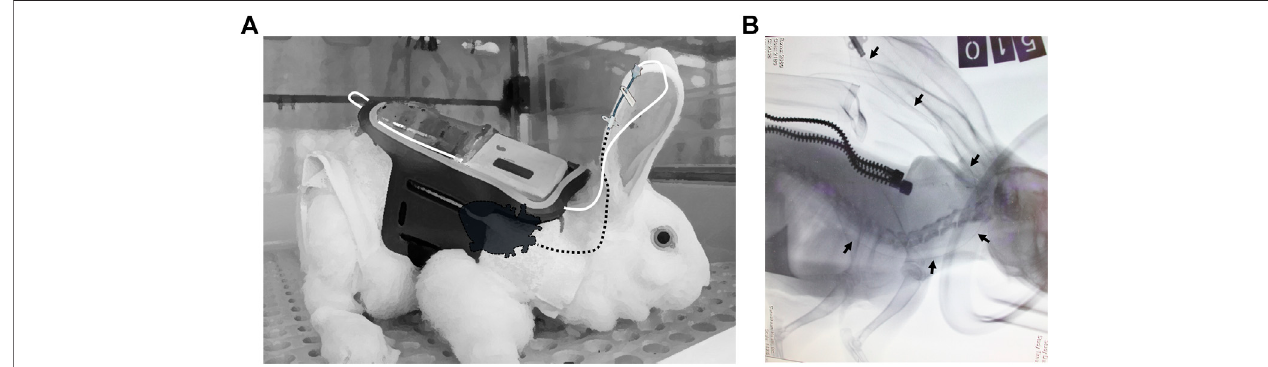
FIGURE1| PICCinsertion (A) Illustrationoftheconnectionbetweenthepumpandcatheter.Thecarriedpumpisharnessedtothebackoftherabbitbyanexternal designatedjacket(white)anda fl exiblepocketadjustedfromanarmband(black).TheexternaltipofthePICCisconnectedtothesyringebyaconnectingline,consisting of two joined fl exible plastic extensors (white line), and the PICC is inserted from the marginal ear vein to the superior vena cava, proximal to the heart (dashed black line, designatinginternal parts). Theadhesive tapethatpreventstheremovalofthePICC isnotillustrated (B) X-rayimagingofthe PICCfrom themarginal earvein tothe superior vena cava. Rabbits were catheterized under iso fl urane anesthesia (the gas mask was imaged). Soft X-ray images were taken at a left lateral posture using an Orange 1040 HF portable X-ray unit tuned to 64 KVP with 4 mas. Images were developed and analyzed using a Point-of-Care CR 360 system. The black arrows show the catheter guide wire location from the marginal ear vein to the superior vena cava (the heart is shadowed). The catheter guide wire was left for the sake of imaging; it was removed afterward before initiating the infusion. The image was taken while the rabbit was carrying the jacket (the zipper is shown).